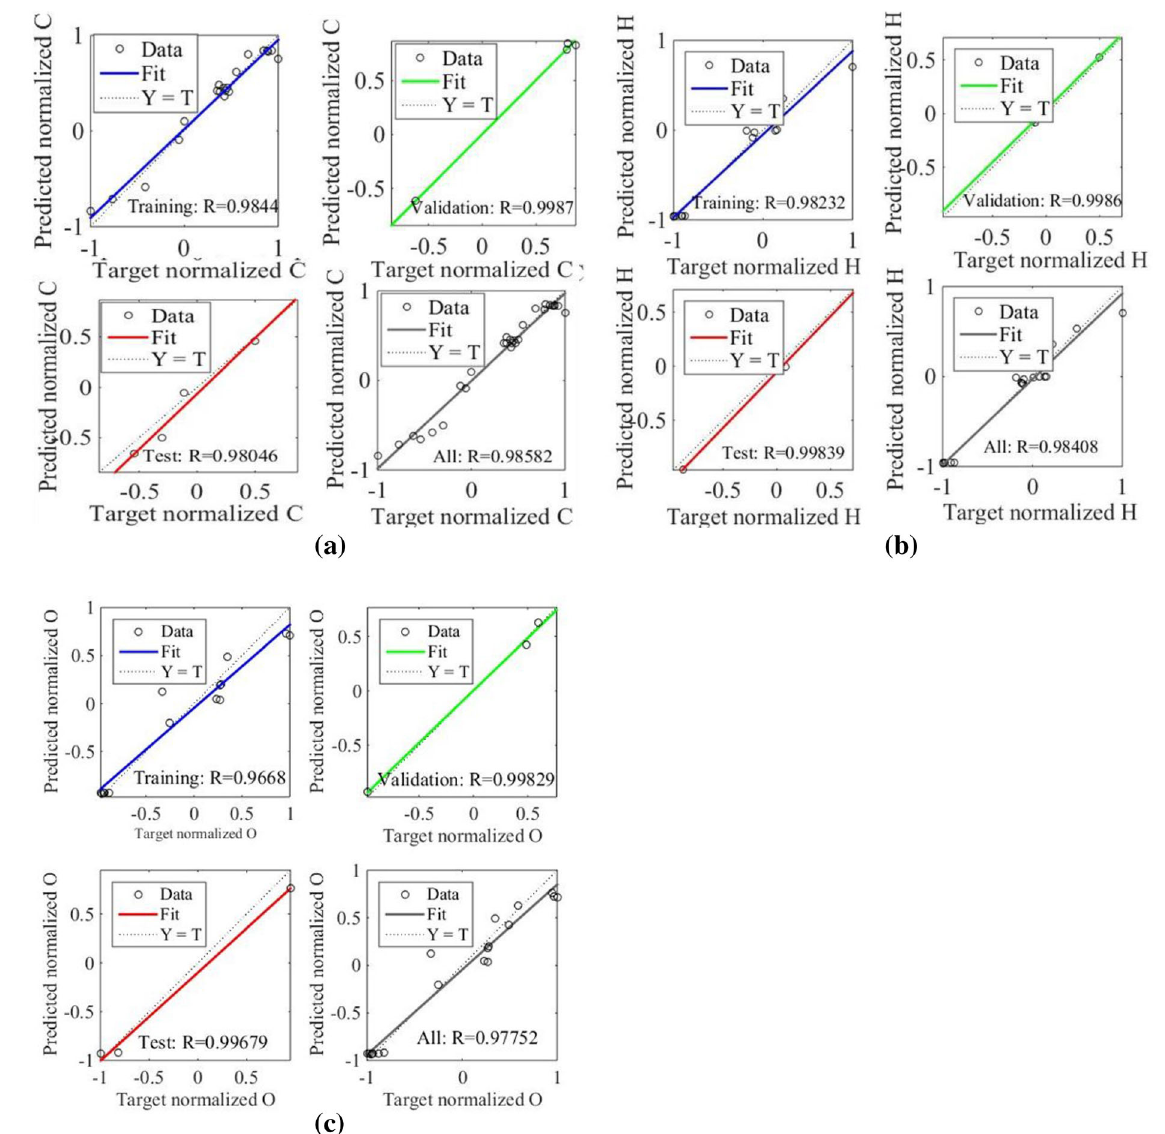
Fig. 3 a Regression graphs for the ANN models for C, b Regression graphs for the ANN models for H, c Regression graphs for the ANN models for O